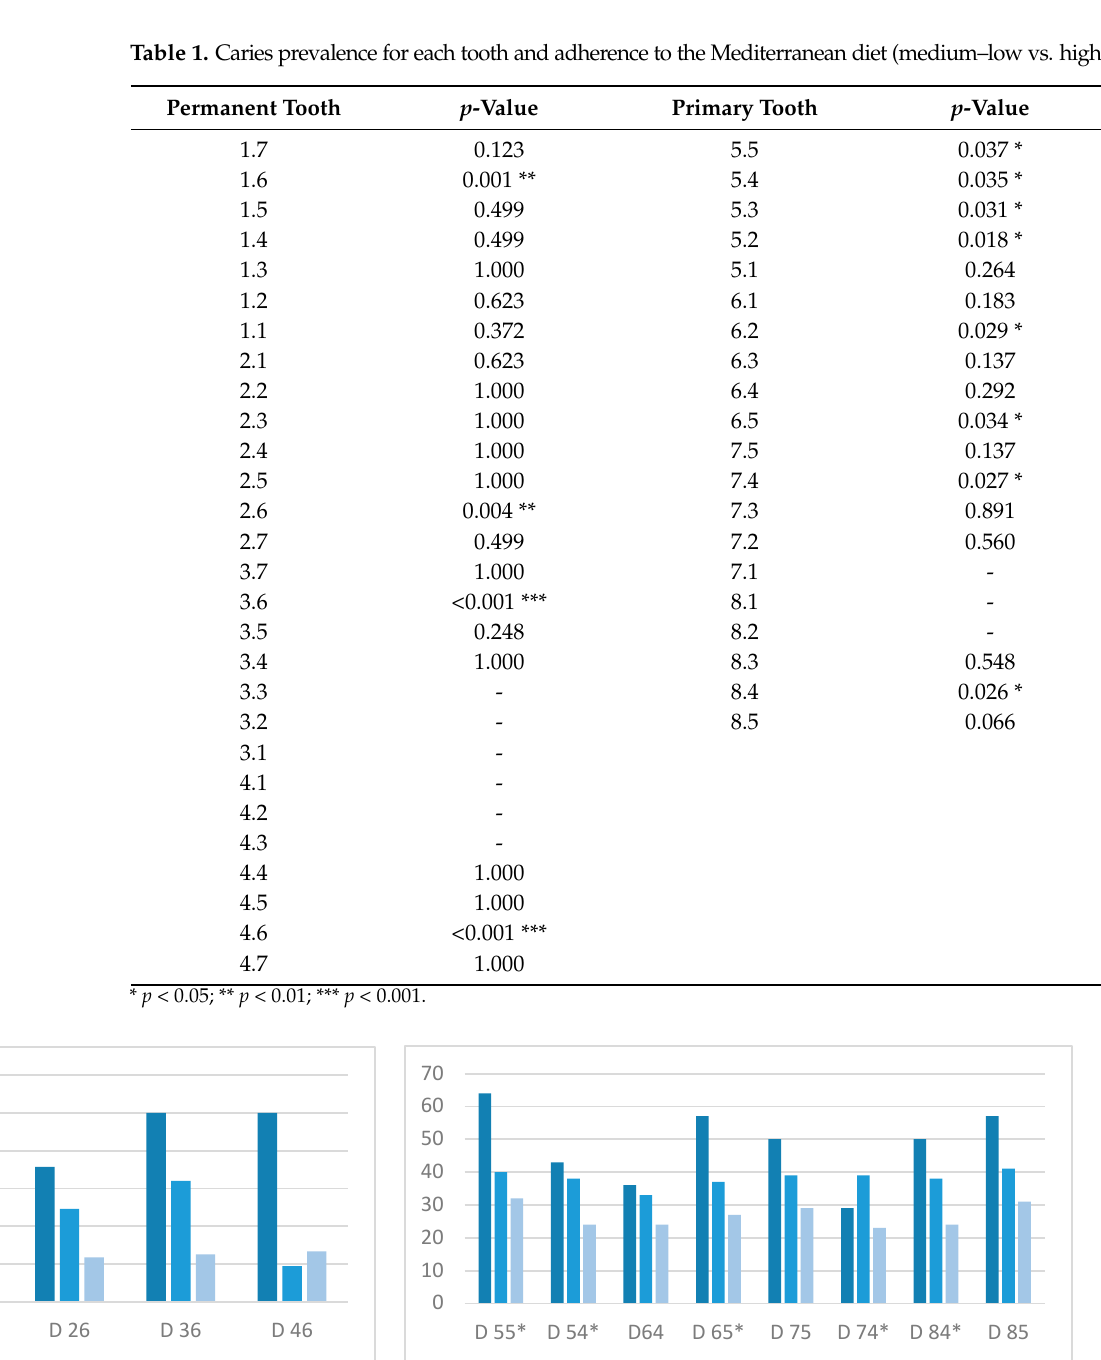
Table 1. Caries prevalence for each tooth and adherence to the Mediterranean diet (medium–low vs. high).